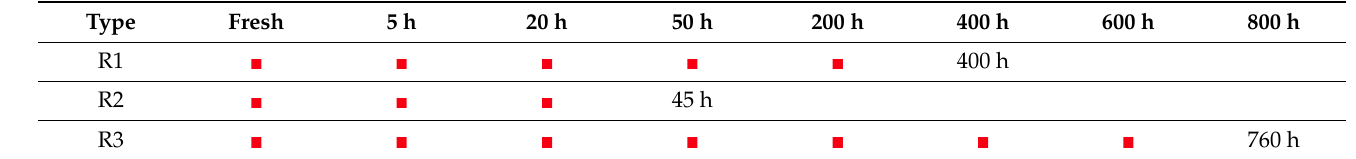
Table 1. Luminous surface of devices R1–R3 under the 85/85